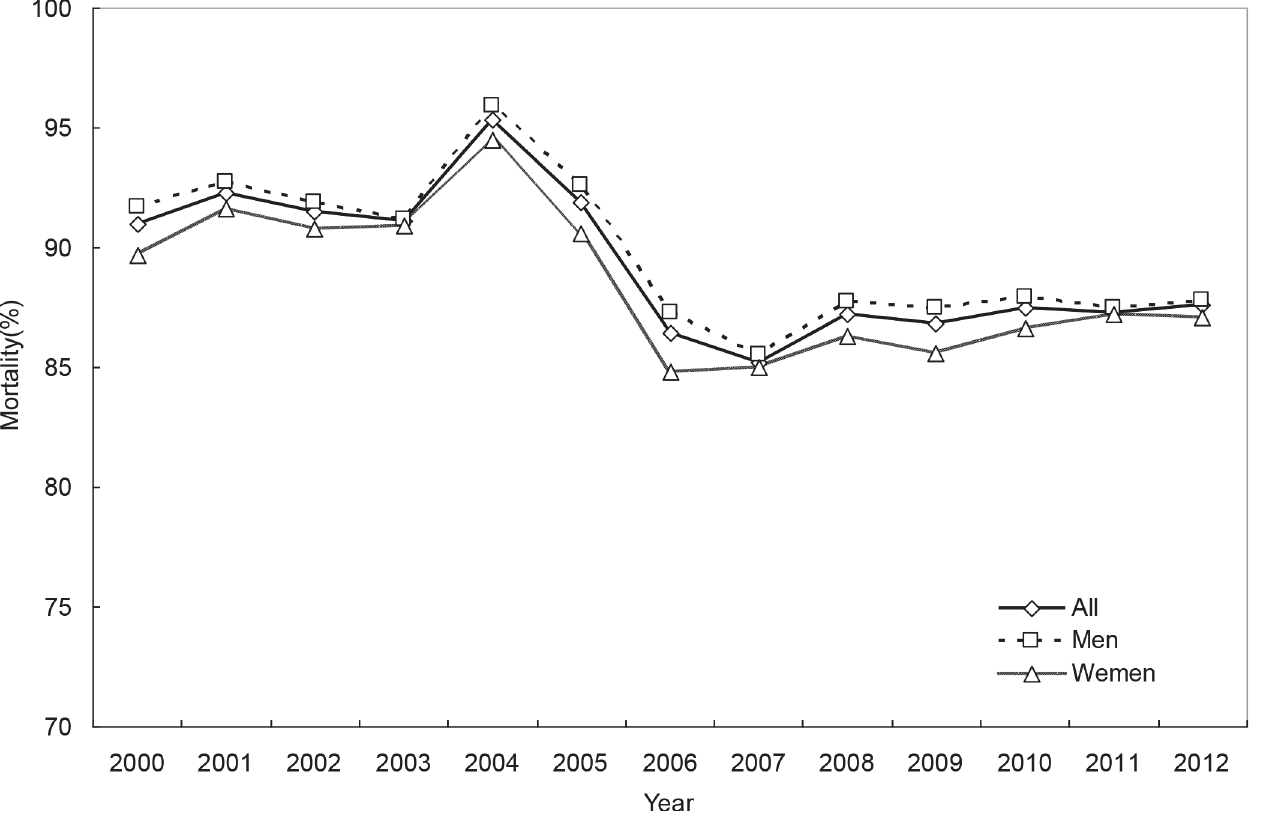
Fig 7. 30-day mortality rates of out-of-hospital cardiac arrest, for both genders combined and by